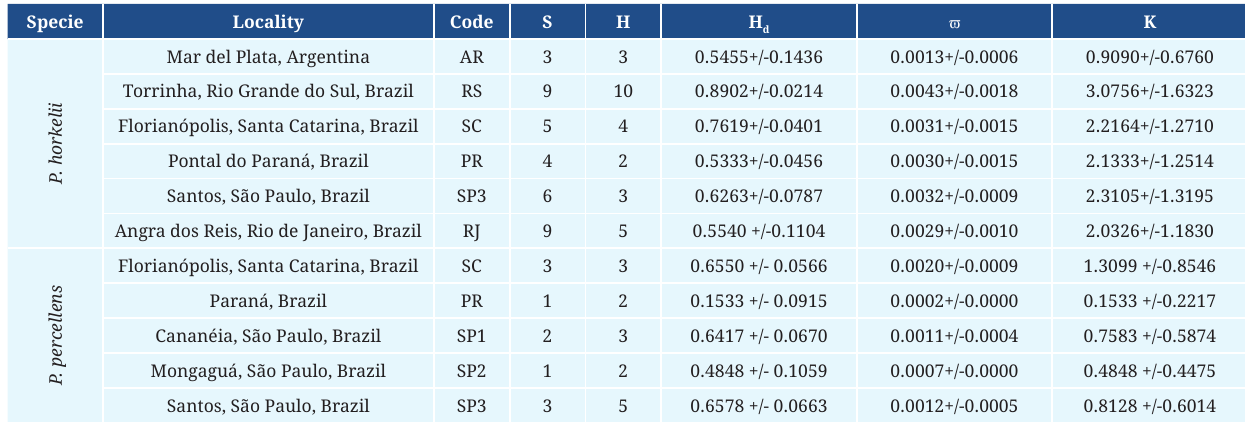
TABLE 2 | Population statistics of Pseudobatos horkelii and P. percellens, based on D-loop . Number of individuals (n), polymorphic sites (S), number of haplotypes (H), haplotype diversity (H